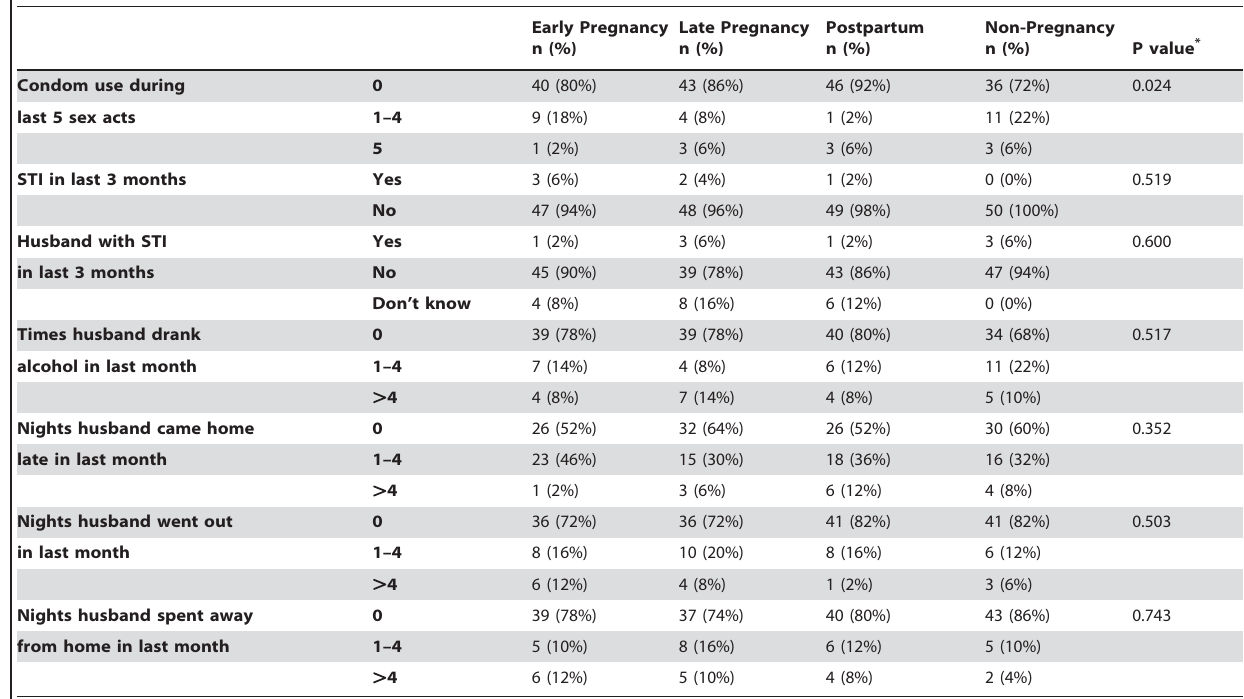
Table 3. Risky behavior by study